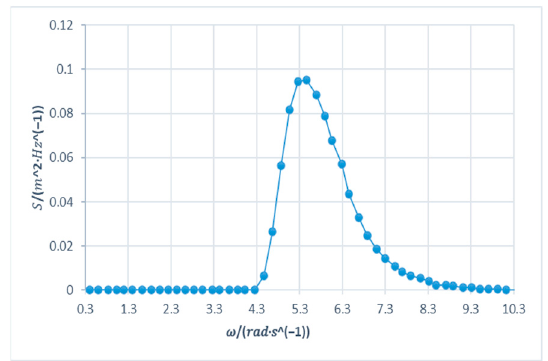
Figure 4. JONSWAP spectrum at Hs = 0.7 m, Tz = 1.55 s.